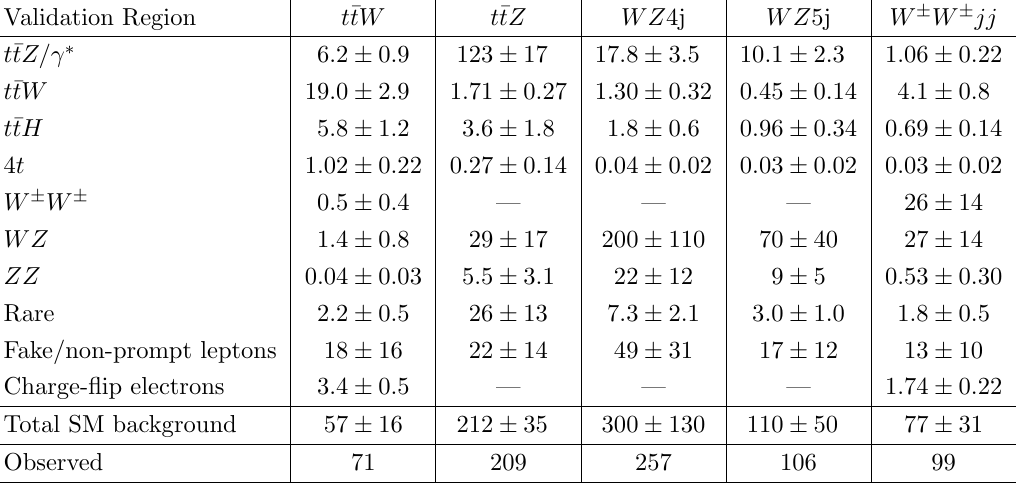
Table 4. The numbers of observed data and expected background events in the validation regions. The rare category is de(cid:12)ned in the text. Background categories with yields shown as \{" do not contribute to a given region (e.g. charge (cid:13)ips in three-lepton regions) or their estimates are below 0.01 events. The displayed yields include all statistical and systematic uncertainties described in section